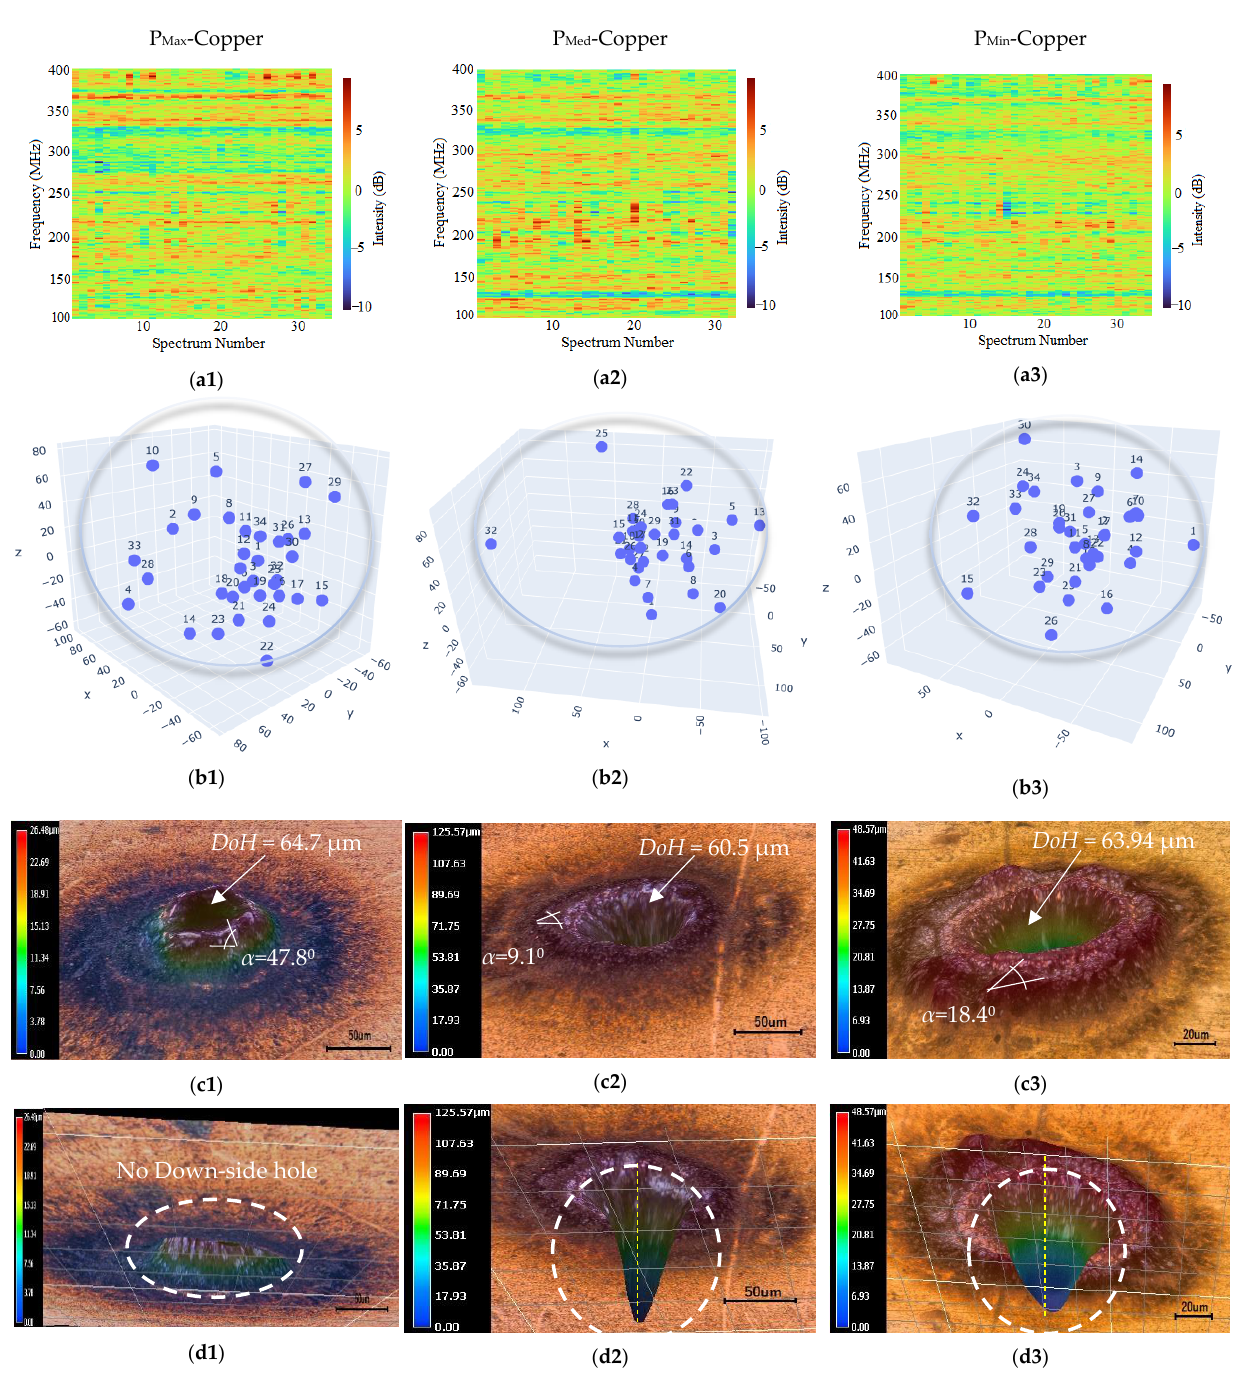
Figure 6. ( a1 – a3 ): RES heat map; ( b1 – b3 ): PCA of RES (where x: first principal component, y: second principal component and z: third principal components of PCA analysis); ( c1 – c3 ): “Up - side” of Microscopic images; ( d1 – d3 ): “ Down- side “of Microscopic images. 1: Maximum Power of laser , 2: Medium Power, and 3: Minimum Power of laser to the Copper target.